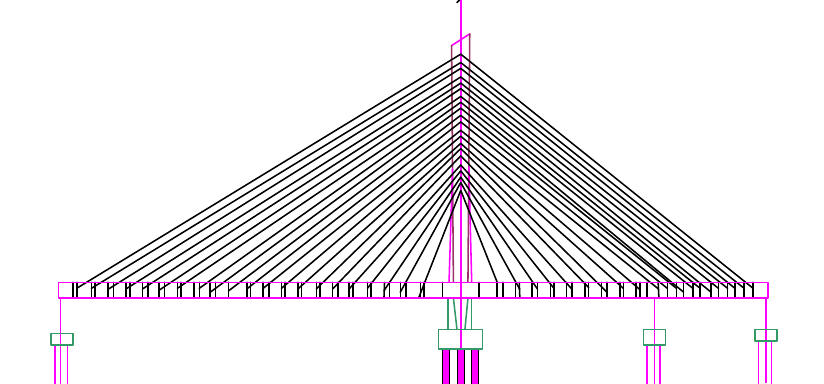
Figure 2 The diagrammatic figure of concrete deck cable stayed